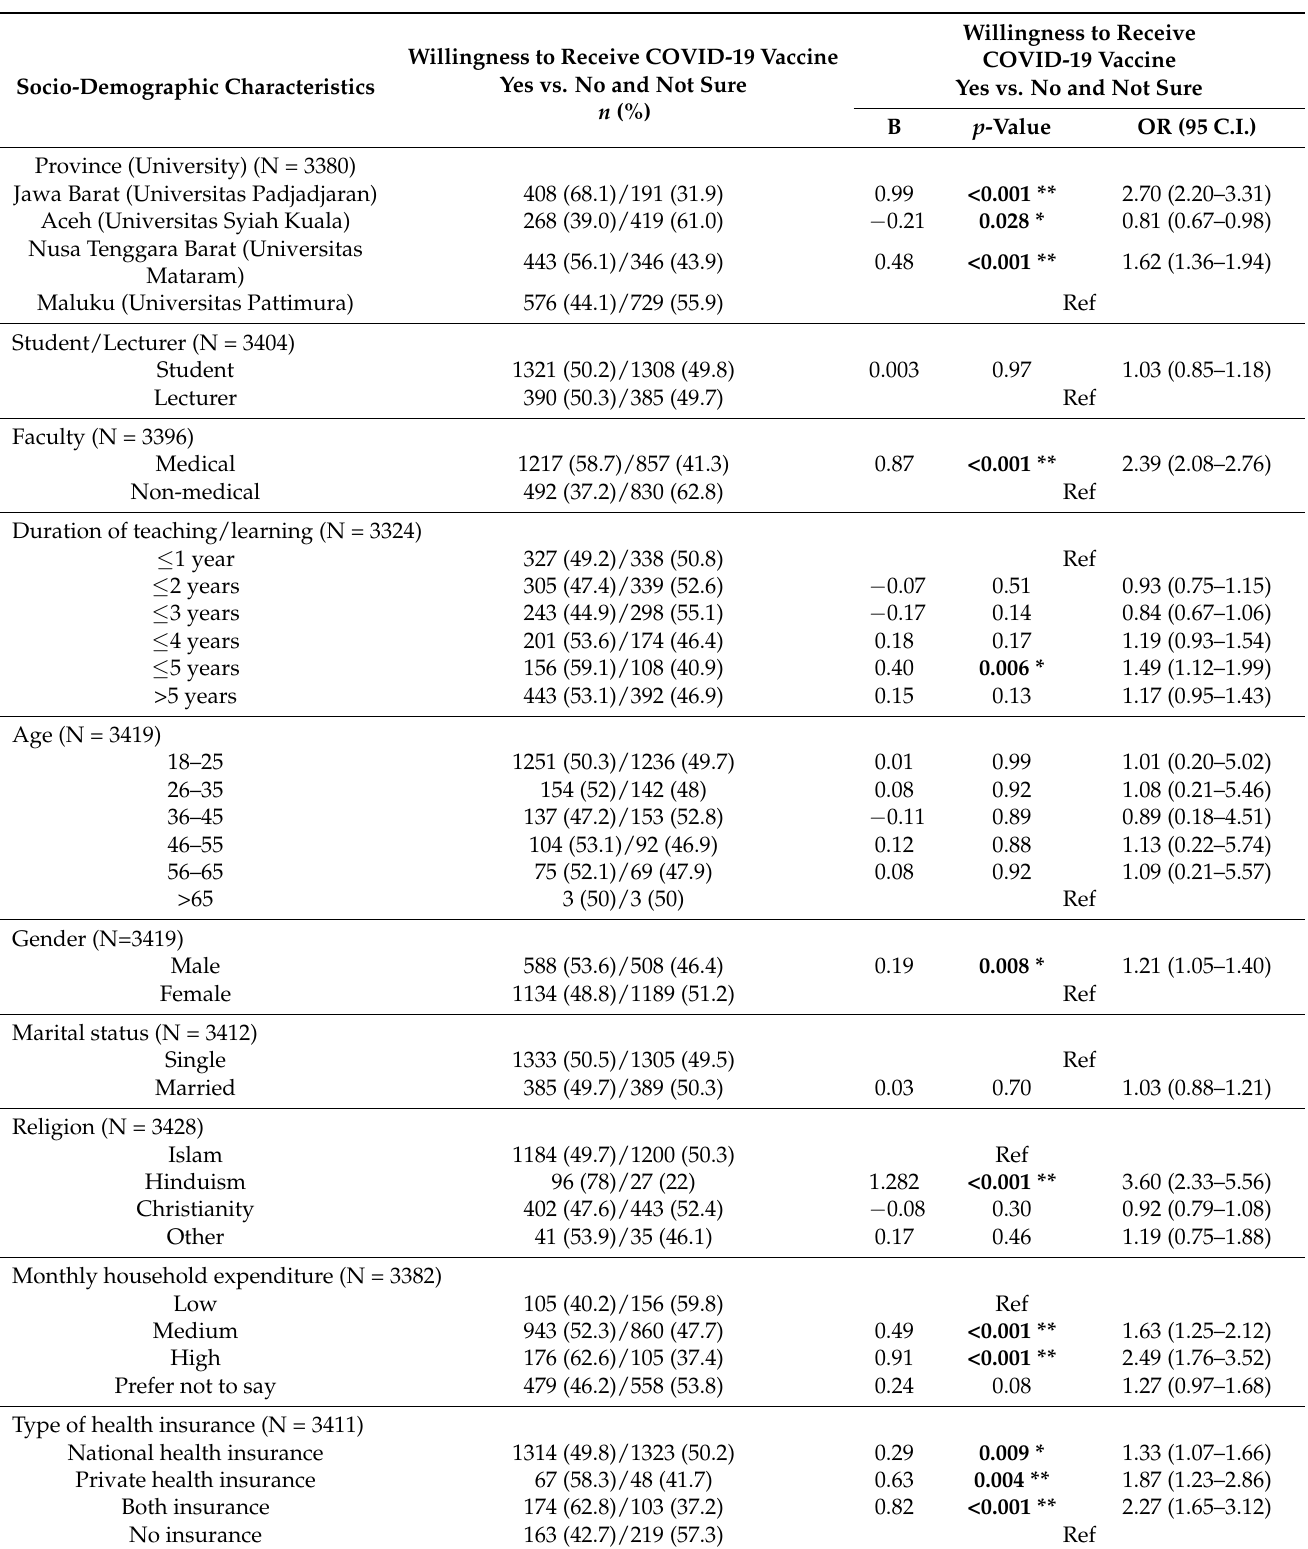
Table 2. Binary logistic regression analysis of willingness to receive COVID-19 vaccine with socio- demographic